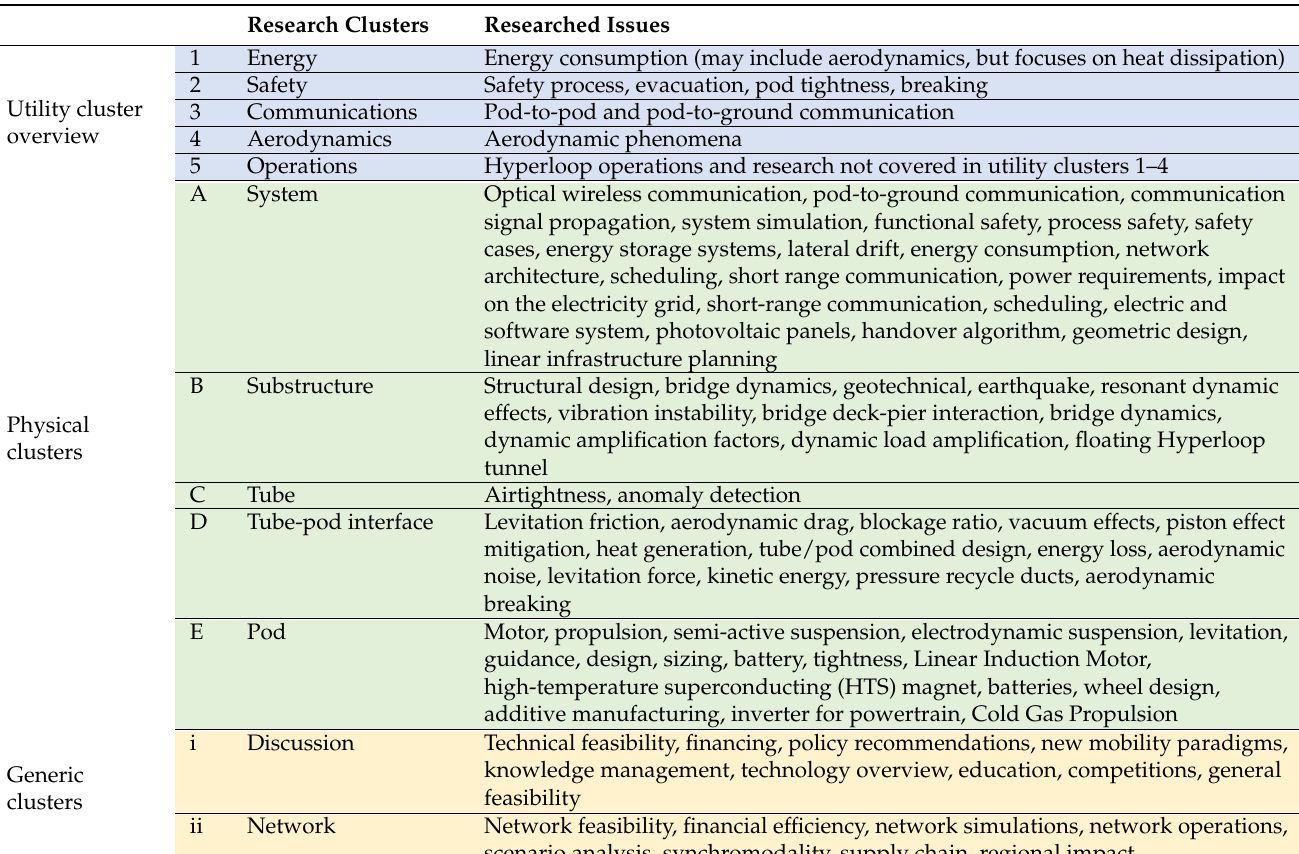
Table 8. A taxonomy of overarching research clusters and research issues on Hyperloop arising from the scientific literature